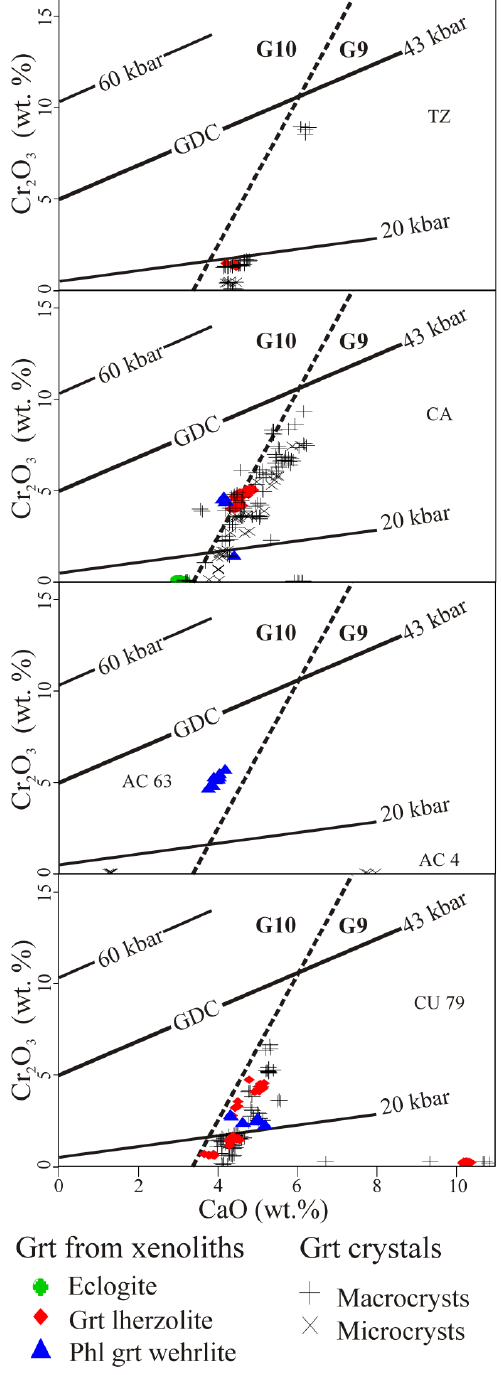
Figure 3. Cr O vs. CaO diagram for garnet with superimposed isobars according to the 2 3 P38 barometer calculation [19]. Graphite-diamond constraint